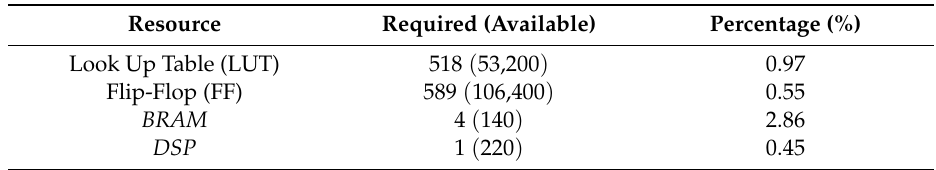
Table 6. Required Resources for the proposed mapping strategy implemented in the Programmable Logic